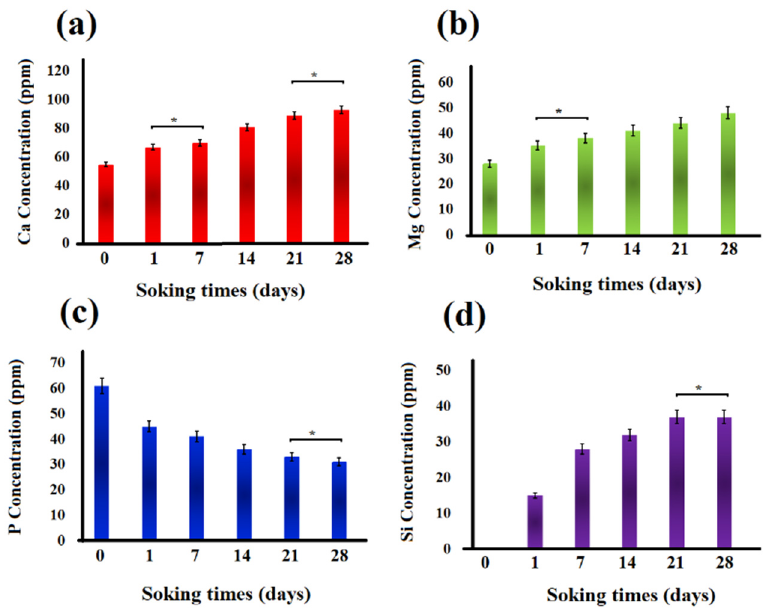
Figure 11. Ion concentration changes in the SBF solution: ( a ) Ca, ( b ) Mg, ( c ) P, and ( d ) Si ions. (* not significantly different).